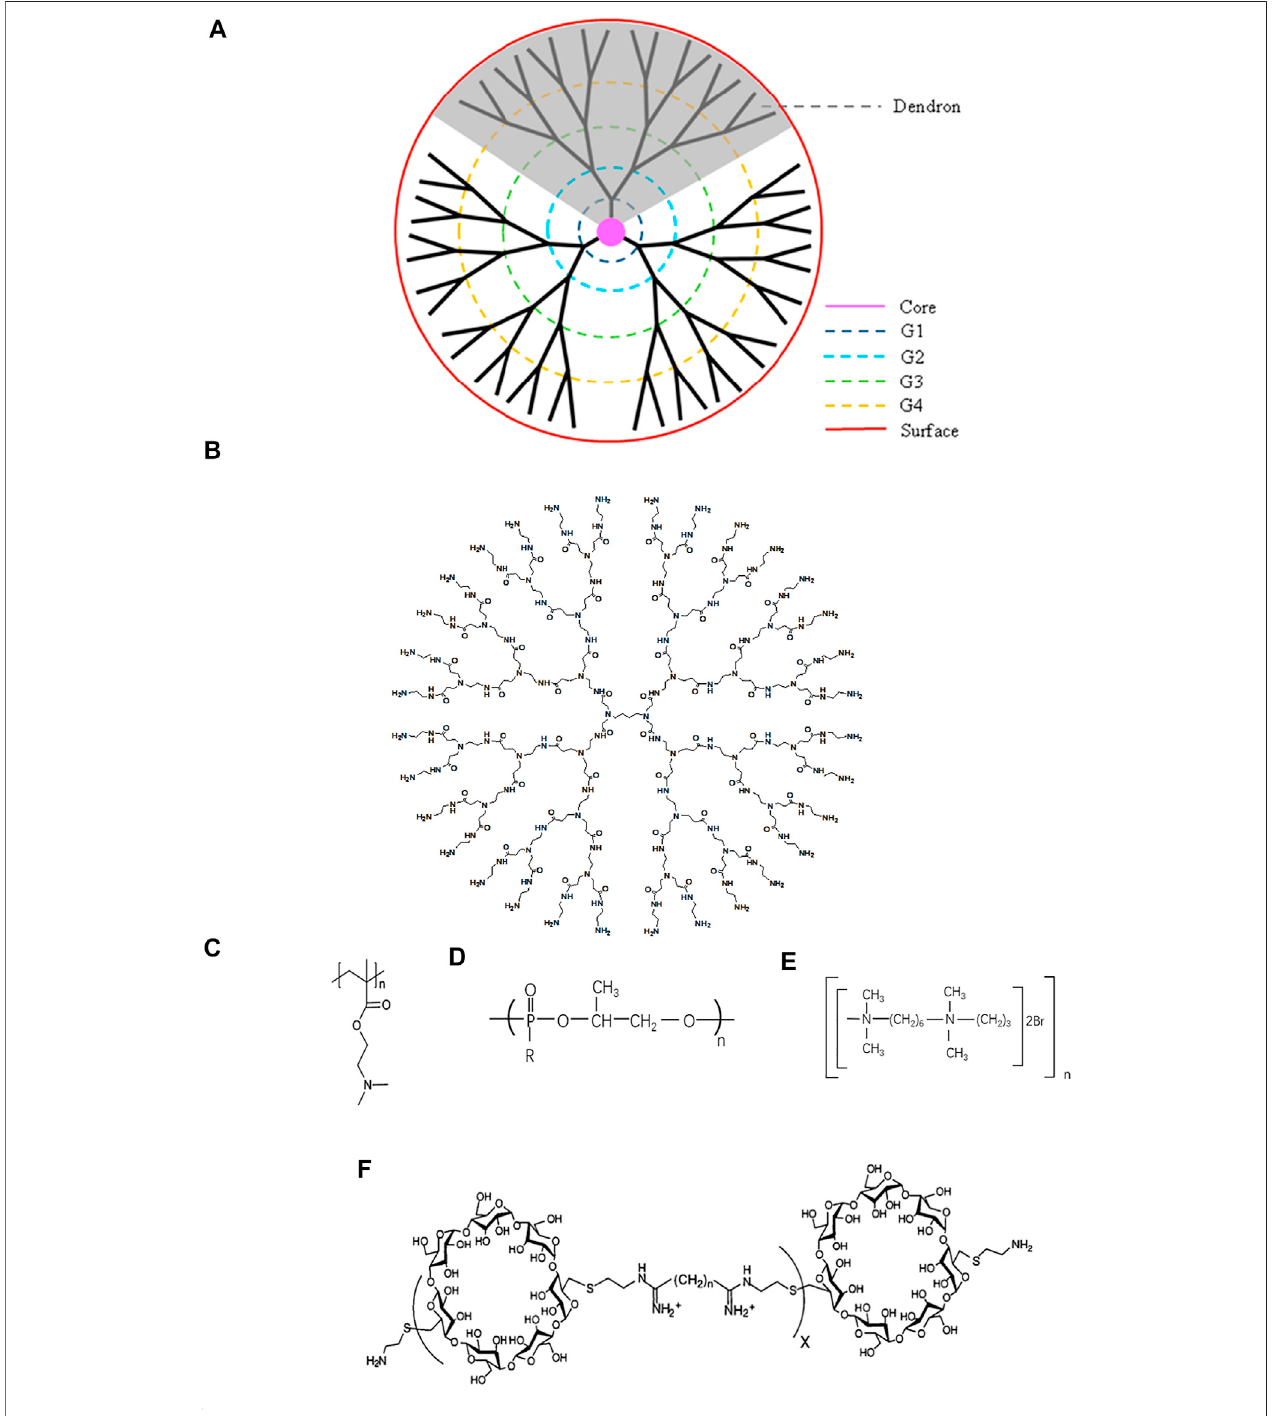
FIGURE 1 | Schematic structure of typical cationic polymers. (A) Dendrimer (Reprint from Reference (Wu et al., 2015)). (B) Genearlation 3 poly (amidoamine) (PAMAM). (C) Poly (2-(diethylamino) ethyl methacrylate) (PDMA) (Reprint from Reference (Samal et al., 2012). (D) Polyphosphoramidate (PPA) (Reprint from Reference (Zhang PC. et al, 2005)). (E) Hexadimethrine bromide (HBMBr) (Reprint from Ref(Aubin et al., 1997)). (F) β -cyclodextrin-containing polycation (CDP) (Reprint from Ref (Hwang et al., 2001)).